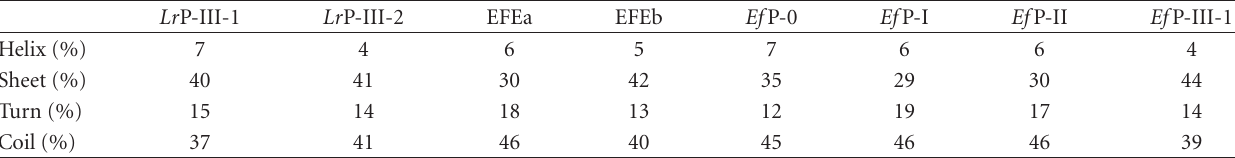
Table 5: Prediction of the secondary structures of the isozymes.